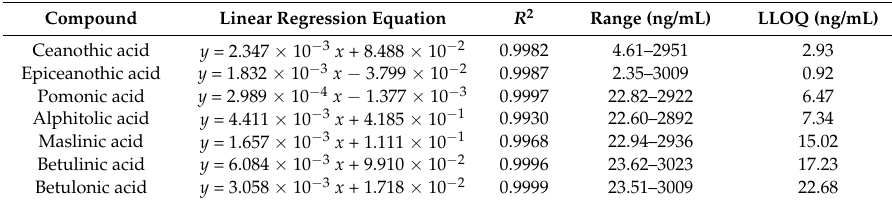
Table 1. Regression equation and LLOQ of seven compounds.